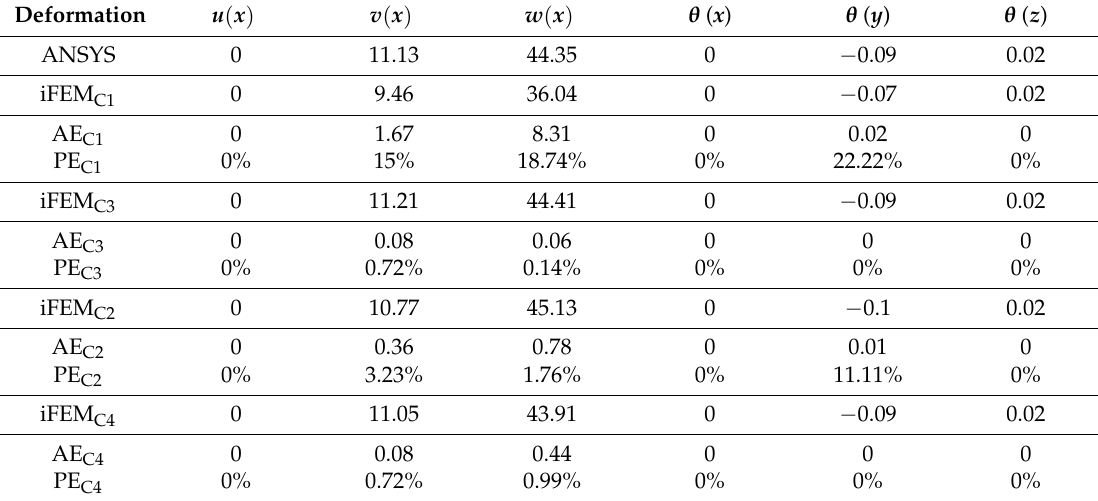
Table 4. Comparisons among deformations computed with iFEM and deformations extracted from ANSYS for complex loads (Loading